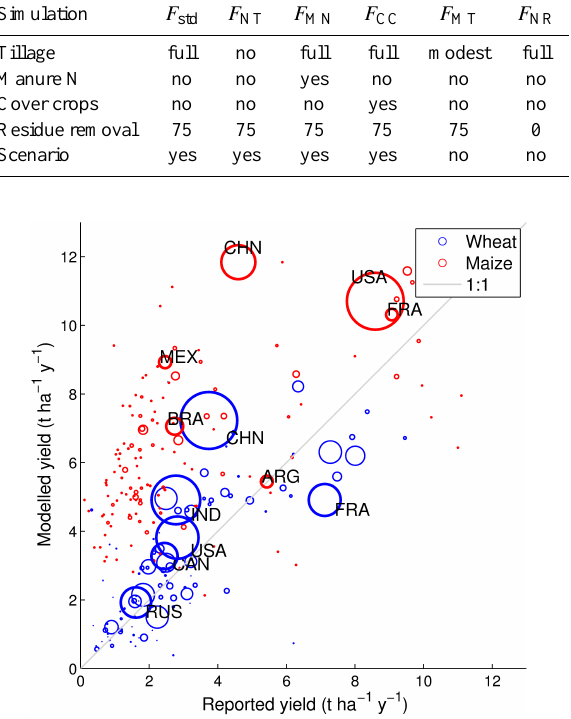
Figure 1. Per-country comparison of simulated yields for WW (wheat) and MA (maize) against reported yields from FAO (1996–2005). Marker size indicates each country’s total